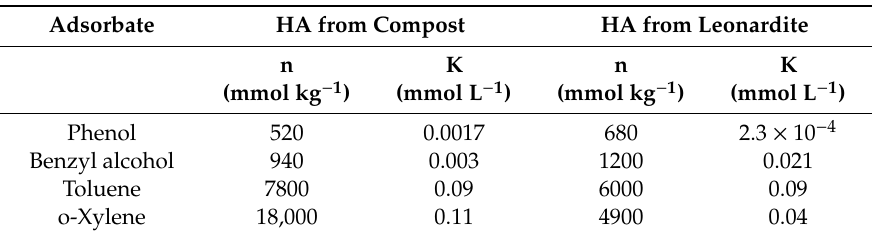
Table 1. Interaction parameters for the binding of benzene derivatives to dissolved humic acids according to the Protein–ligand like model (adapted from [91]).